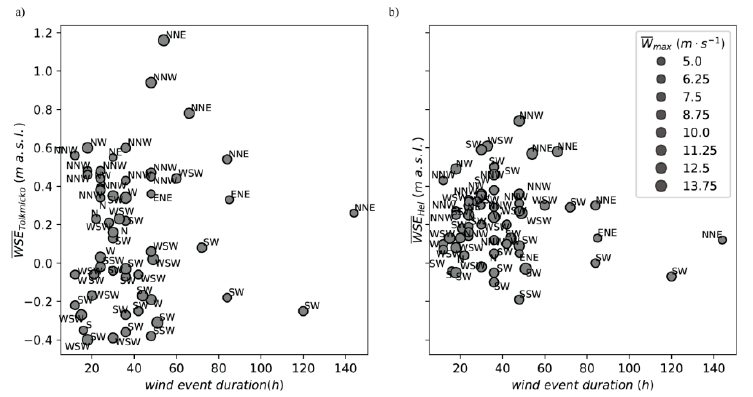
Figure 8. Averaged water levels (WSE) at ( a ) Tolkmicko, ( b ) Hel versus wind event duration time. Label denotes the dominating wind direction, size denotes the observed maximum wind speed.